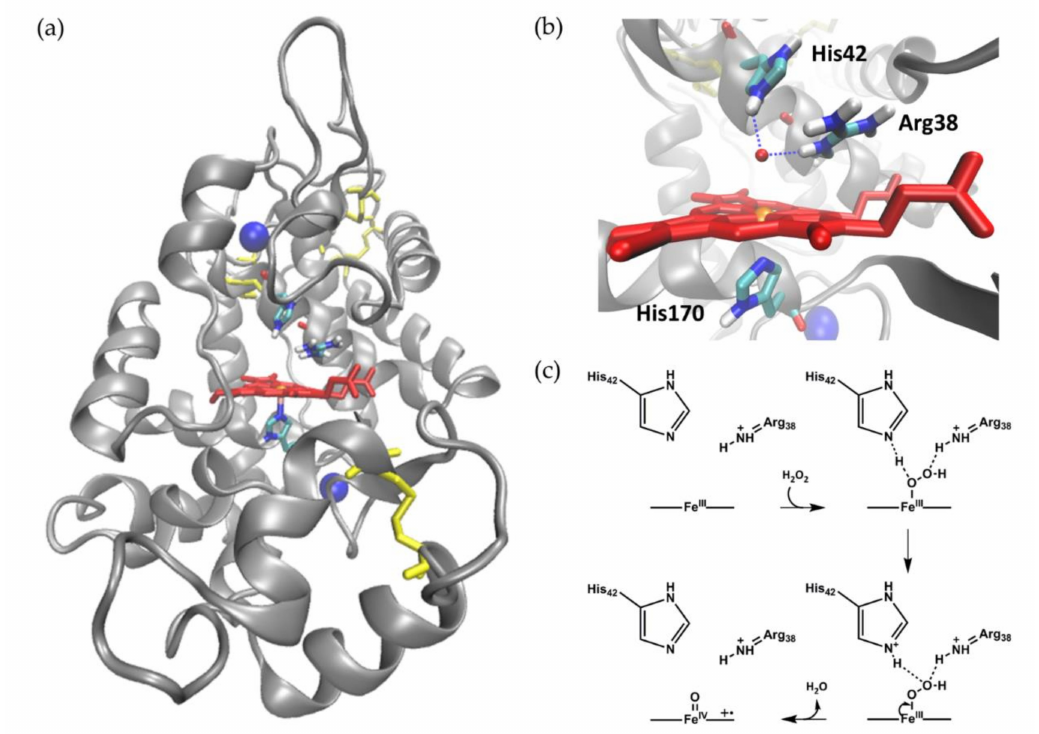
Figure 1. Crystal structure of HRP and mechanism for hydrogen peroxide reduction. ( a ) Overall globular structure of HRP C1A. The polypeptide chain is shown as the grey cartoon, the heme cofactor, disulfide bonds, and selected amino acids as red, yellow, and multi-colored sticks, respectively. The two calcium ions are shown as blue spheres. ( b ) Active site of HRP C1A with the heme cofactor depicted as red sticks with the iron center as orange sphere. The essential amino acids Arg38, His42, and His170 are shown as sticks colored by element. Structures were visualized using PDB 1ATJ [33] and VMD 1.9.3 [37]. From Neumann, 2019 [38]. ( c ) Proposed mechanism for hydrogen peroxide reduction by heme peroxidases and concomitant Compound I formation. Adapted with permission from Rodr í guez-L ó pez et al., 2001 [34]. Copyright (2001) American Chemical